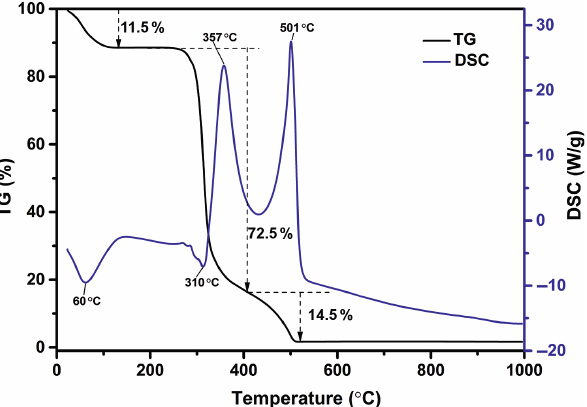
Figure 2: TG/DSC diagrams of starch.